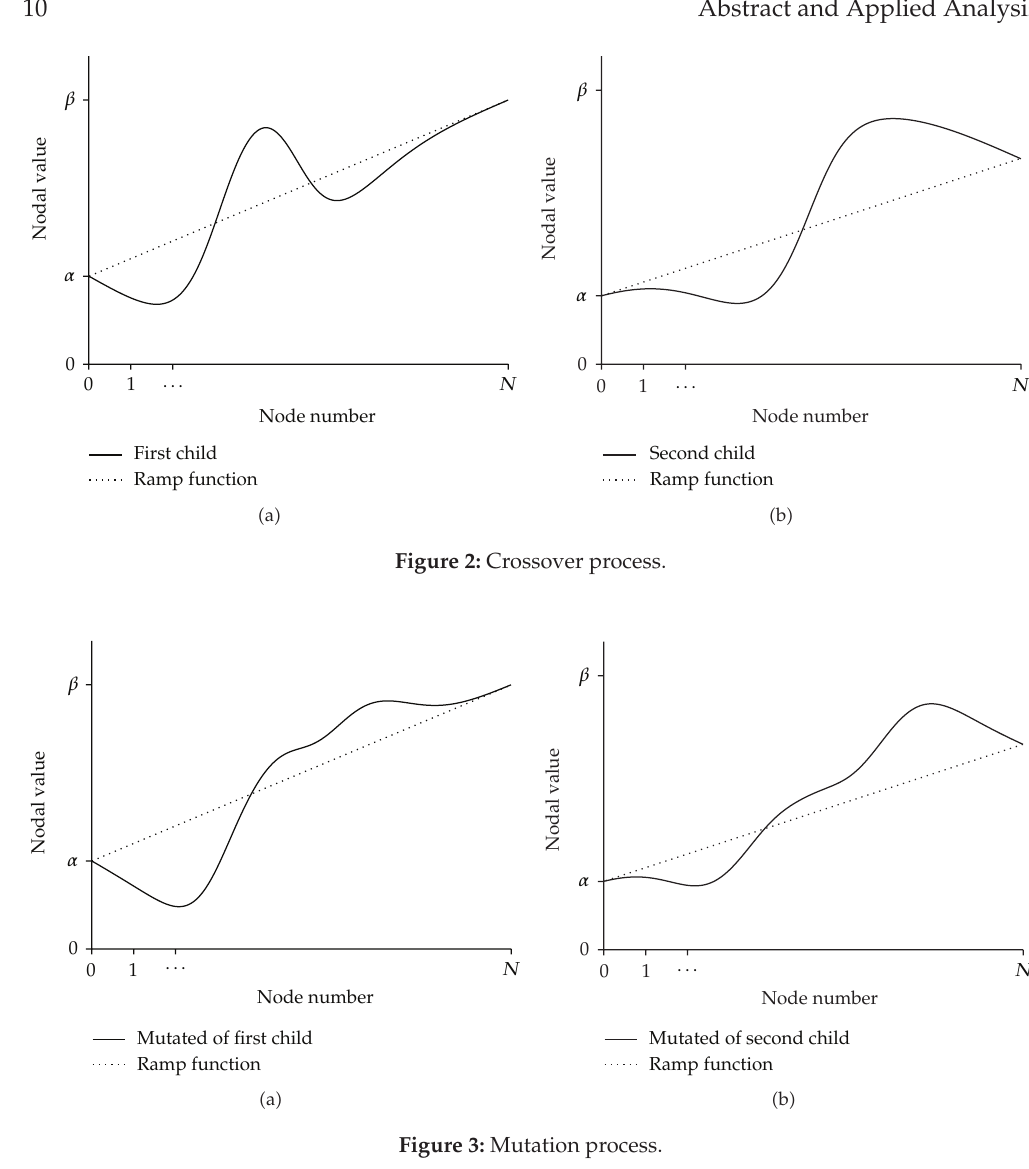
Figure 2: Crossover process.